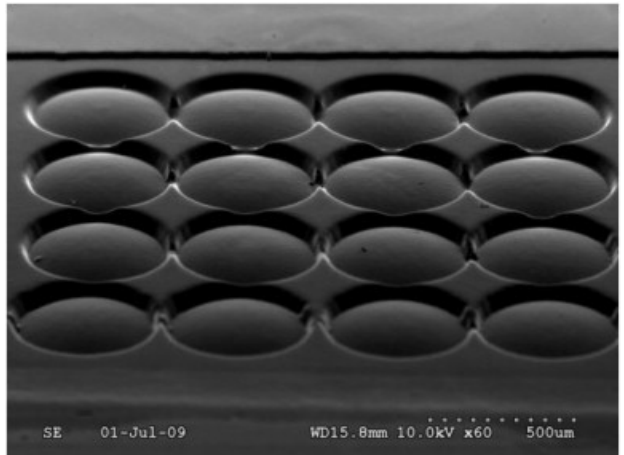
Figure 14. Laser-machined micro lens array with aspheric shape using an excimer laser Reproduced with permission from [155].